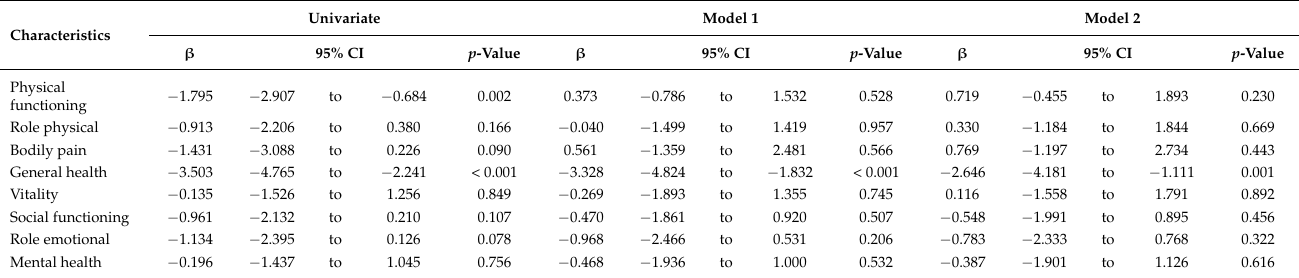
Table 3. Correlation between SF-36 scores and HOMA-IR